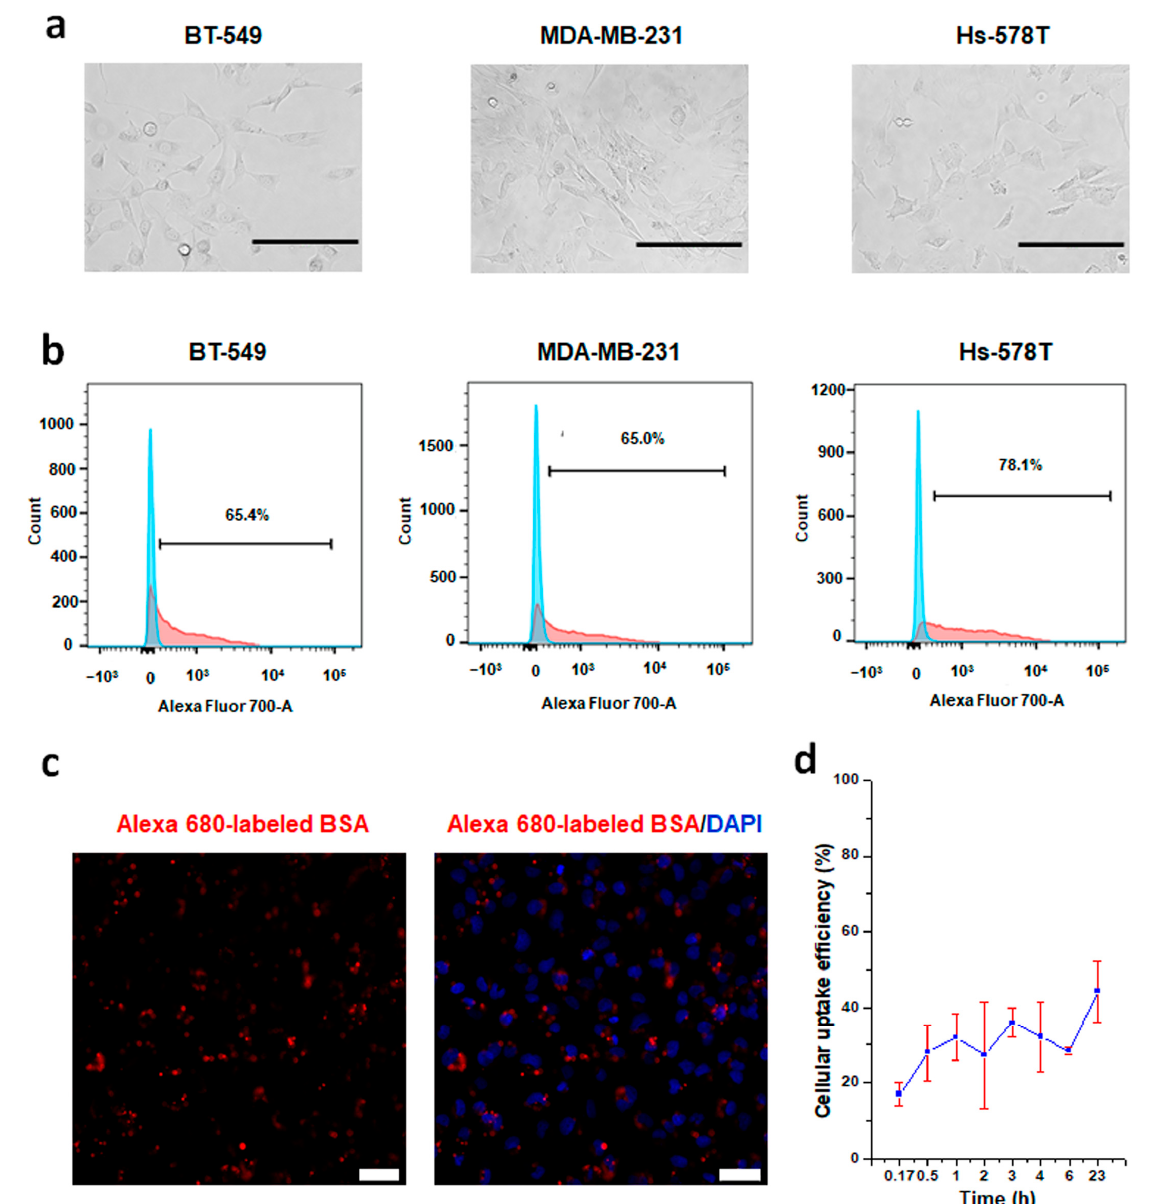
Figure 2. Establishment of a CRISPRMAX-based protein delivery system using the Alexa 680-labeled BSA as a model protein. ( a ) Bright-field images of three different mesenchymal breast cancer cell lines were taken at 200 × magnification (scale bars, 200 µ m). ( b ) Single-parameter histograms for comparison of the negative control (cells transfected with ddH 2 O, blue) and the positive population (the cell of interest, red): ( left ) BT-549 cells were seeded at the density of 8000 cells/well, and FCM was conducted at day 4 after transfection with fluorescent BSAs; ( middle ) MDA-MB-231 cells were seeded at the density of 4000 cells/well, and FCM was conducted at day 2 after transfection with fluorescent BSAs; ( right ) Hs-578T cells were seeded at the density of 8000 cells/well, and FCM was conducted at day 2 after transfection with fluorescent BSAs. Each kind of cell was transfected with 500 ng of BSA-Alexa Fluor 680 per well through CRISPRMAX. ( c ) CLSM analysis of BT-549 cells transfected with fluorescent BSAs delivered by CRISPRMAX. Fluorescent excitation and emission for BSA-Alexa Flour 680 were 633 and 702 nm, respectively. Confocal images were taken at 200 × magnification (scale bars, 50 µ m). ( d ) Cellular uptake efficiency of BSA-Alexa Fluor 680 delivered by CRISPRMAX within 24 h in BT-549 cells. CLSM, confocal laser scanning